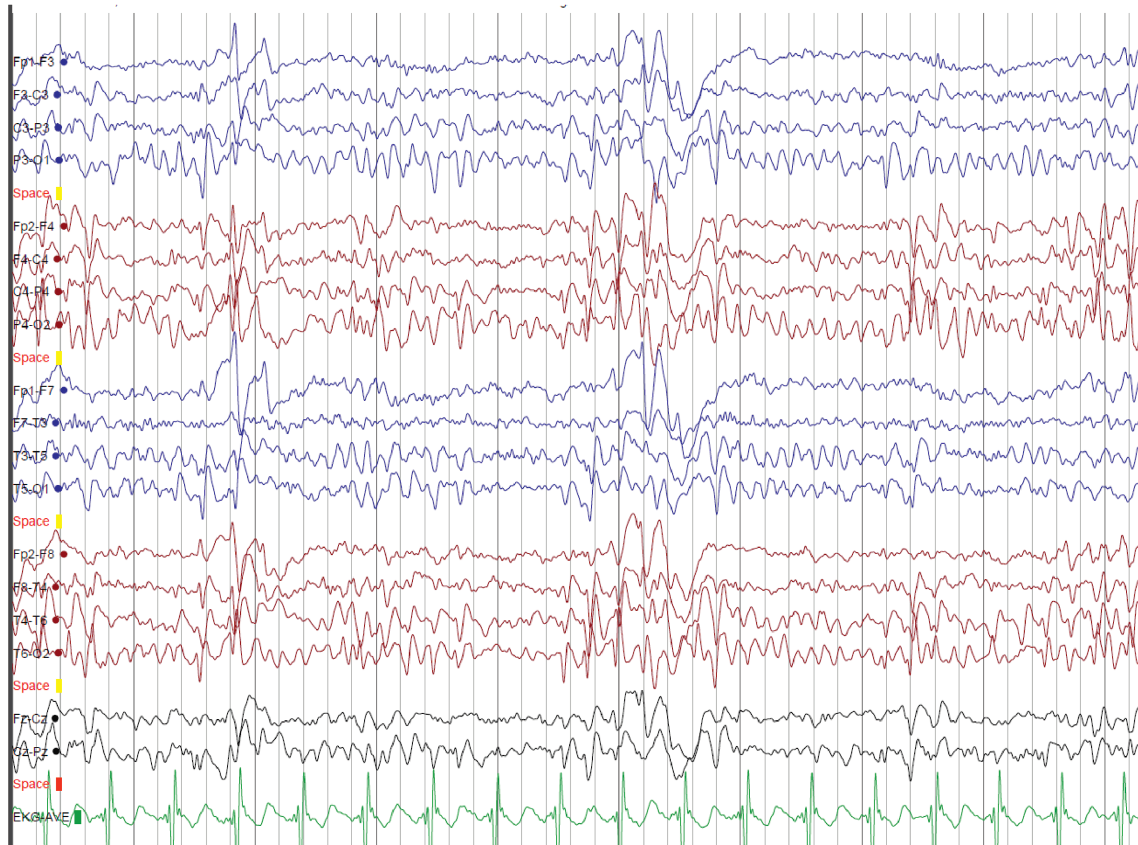
Figure 1: EEG showing predominant centrotemporal spikes and waves on the right side (voltage